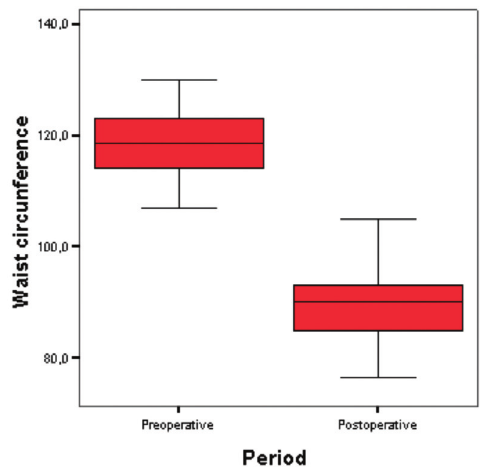
Figure 2 - Waist circumference (preoperative and postoperative)